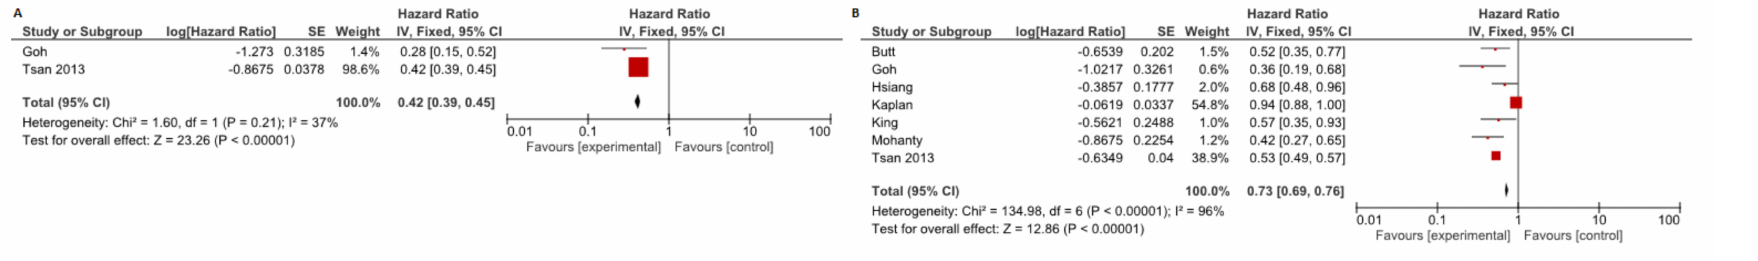
Figure 3. Hazard ratio for HCC occurrence in the comparison between statin users and non-users. ( A ) Crude HR. ( B ) Adjusted